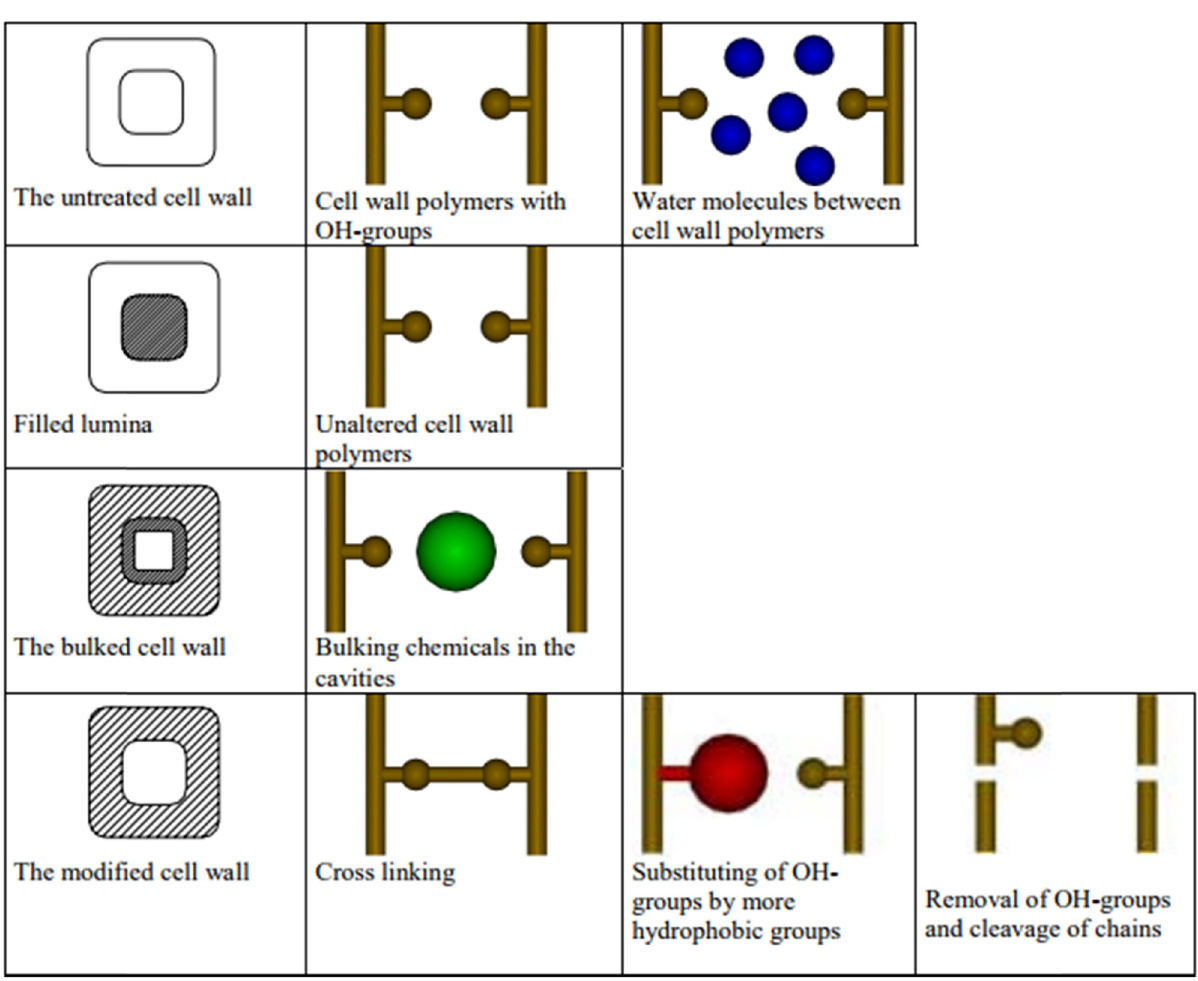
Figure 1: Cell wall reaction diagram of di ff erent chemical modi fi cations [ 18 ]